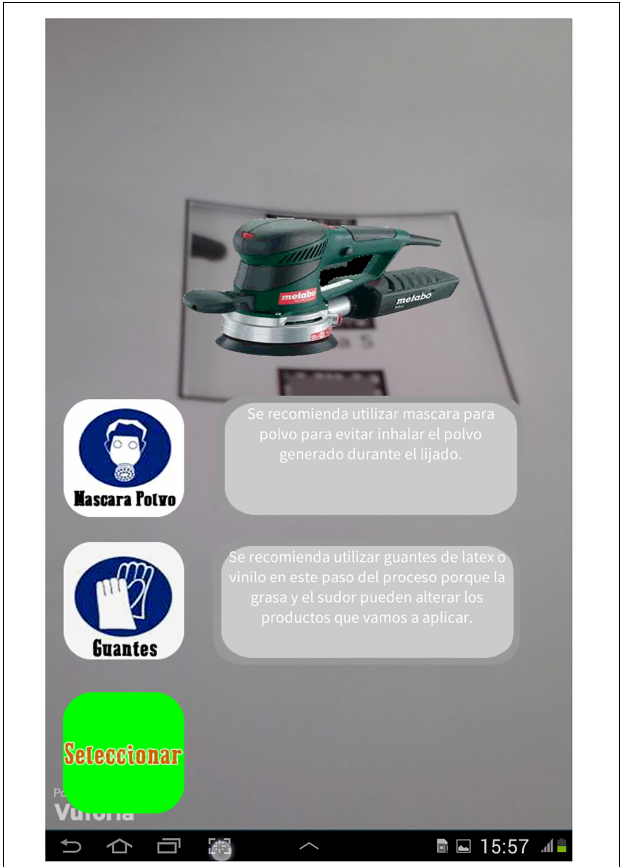
FIGURE 1 | A screenshot of the Paint-cAR application in the AR